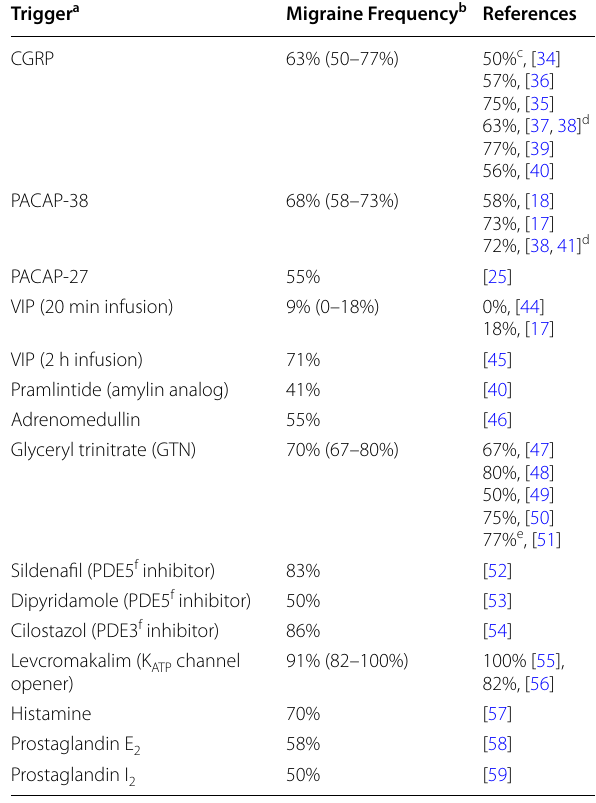
Table 1 Comparison of migraine frequencies after infusion of CGRP, PACAP, and other triggers in